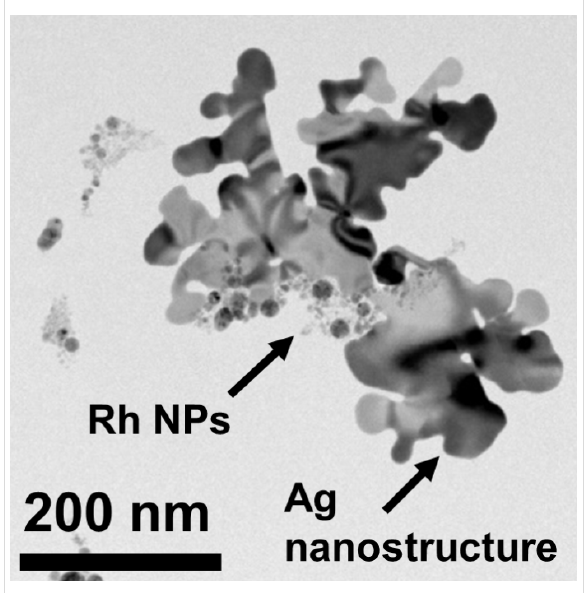
Figure 1: Ag–Rh heterostructures formed after mixing colloidal Ag and Rh suspensions generated via pulsed laser ablation. Rh nanoparticle groupings were observed to only adsorb to Ag nanostructure concavi- ties. Similar Ag–Pt heterostructures formed in the mixtures of colloidal Ag and Pt suspensions.